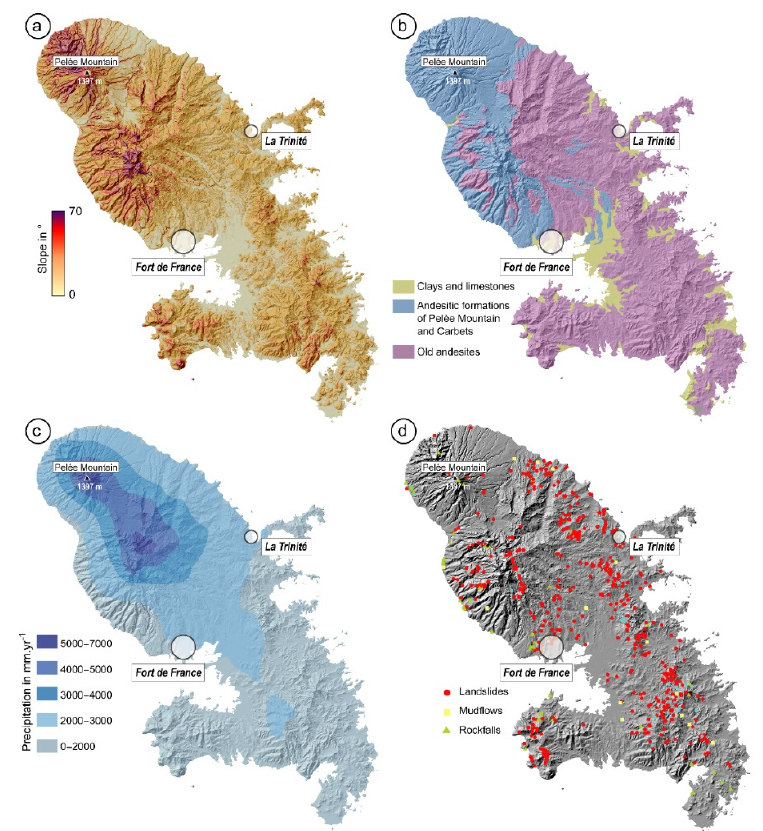
Figure 1. Location of La Martinique (the names of main cities are given in italics); ( a ) slope map; ( b ) simplified geological map; ( c ) precipitation map (mean annual rainfall per year); ( d ) landslides: type and locations (from French national landslide database: BD-MVT,